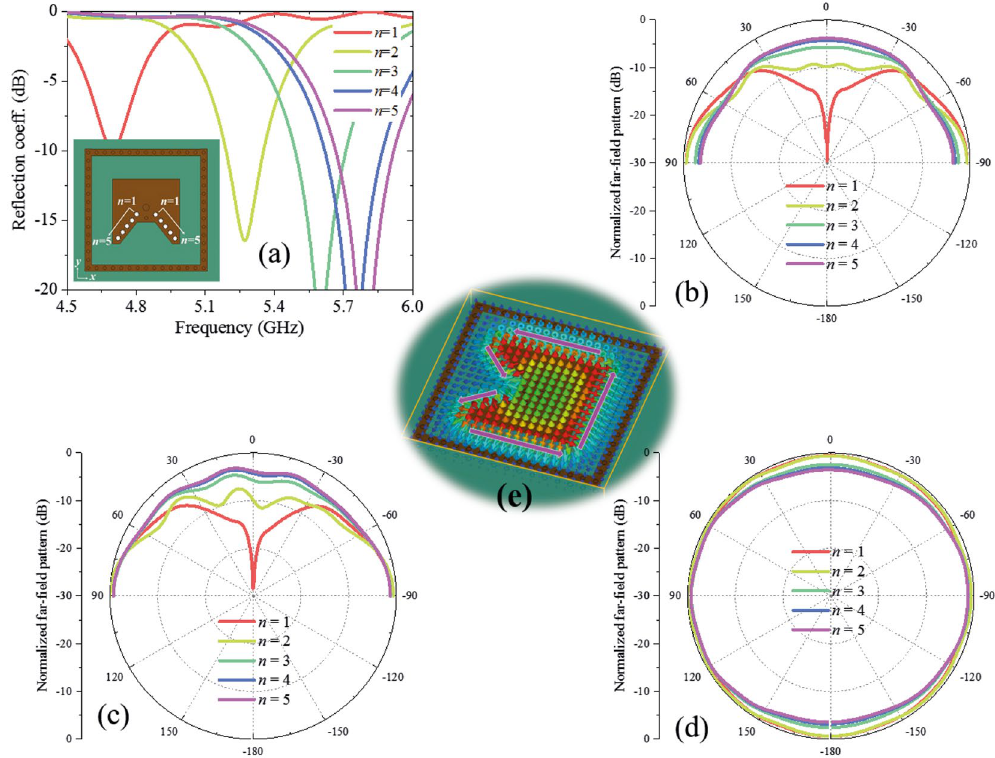
Figure 3. Relations between the number n of the grounded holes on short edge and antenna performances. ( a ) Reflection coefficient versus number n . The insert figure shows the grounded holes discussed here, which are marked as white circles. The distance between adjacent grounded holes are fixed and positions of the grounded holes are shown in Fig. 2. Normalized radiation patterns in xz plane, yz plane, and xy plane at 5.8 GHz versus number n are shown in ( b – d ), respectively. With the decreasing of grounded holes, radiation on z-direction decreases. ( e ) Electric field distribution at 5.8 GHz on the case of n = 1. The equivalent magnetic currents are marked in the figure, which compose a magnetic current loop. In the calculation, the ground is set as